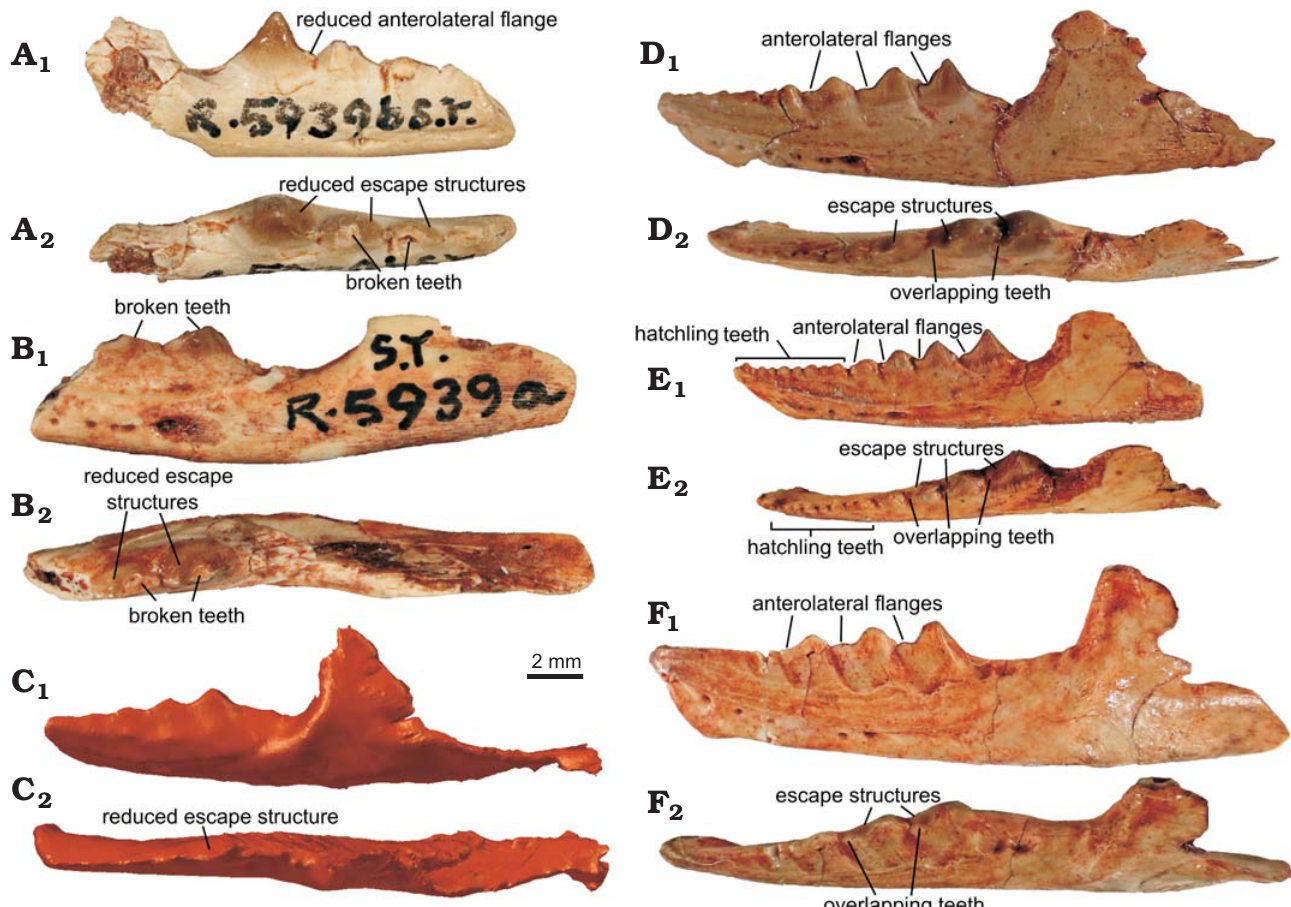
Fig. 3. Dentaries of lepidosaur rynchocephalian Clevosaurus hudsoni Swinton, 1939 from Rhaetian, Cromhall Quarry, England, UK, including the two syntypes (A, B) belonging to W.E. Swinton’s collection. A . NHMUK ST R5939b. B . NHMUK ST R5939a. C . NHMUK PV R36832. D . R 37270, note the highly worn hatchling teeth. E . NHMUK PV R 37271, note the presence of hatchling teeth. F . NHMUK PV R 37272. In lateral (A 1 –F 1 ) and dorsal (A 2 –F 2 )